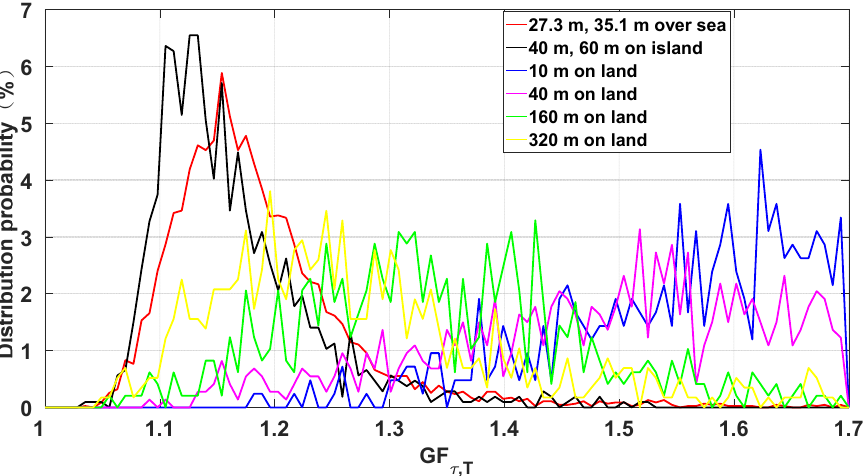
Figure 11. Distribution probability of GF u with gust averaged time τ = 3 s and wind speed averaged time T = 10 min.